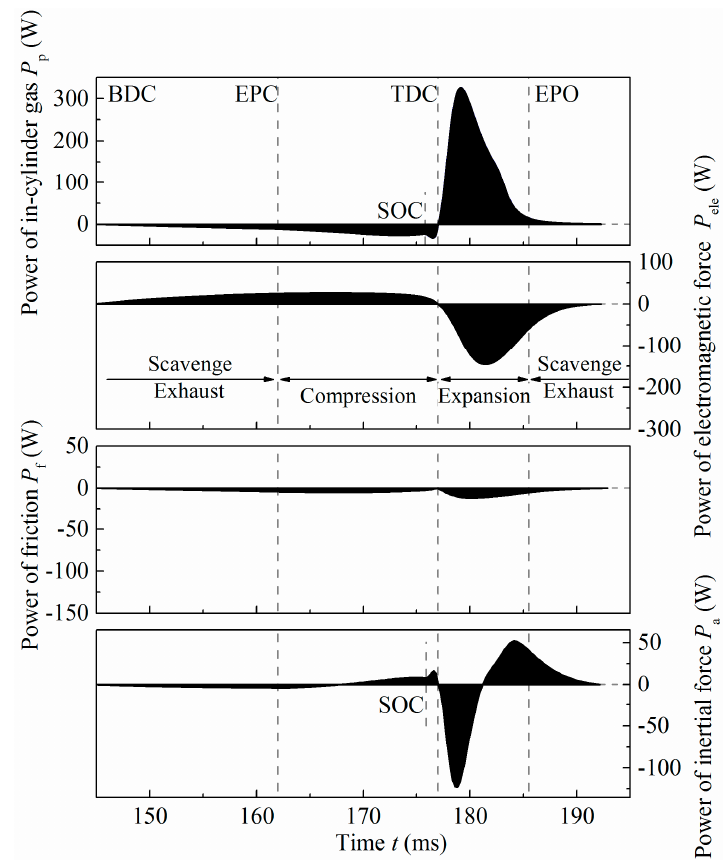
Figure 11. Simulations of the transient powers of the forces imposed on the piston in a complete cycle.